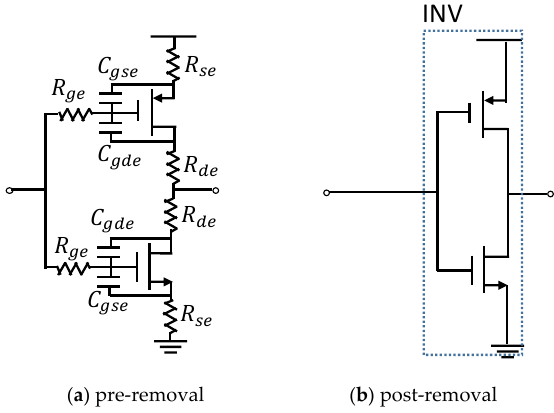
Figure 5. The inverter with resistors and capacitors.